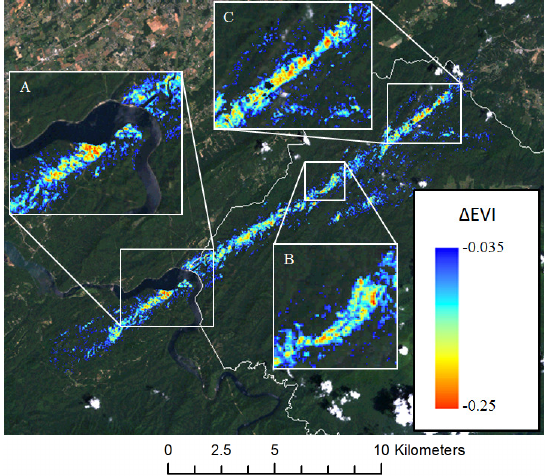
Figure 3: Damage severity over the areas affected by the April 27, 2011 tornado in the Great Smoky Mountains National Park, represented by anomalies of the Enhanced Vegetation Index ( Δ EVI). Lower anomaly values (red color) indicate higher